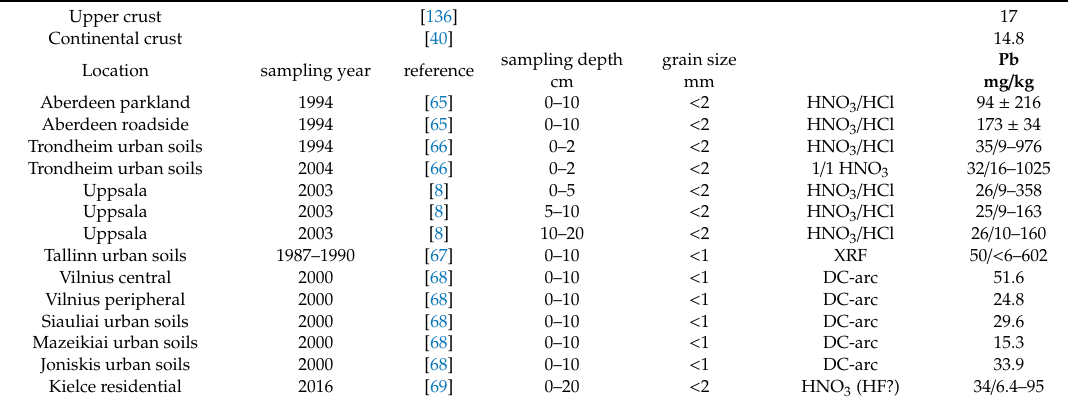
Table A16. Lead in urban